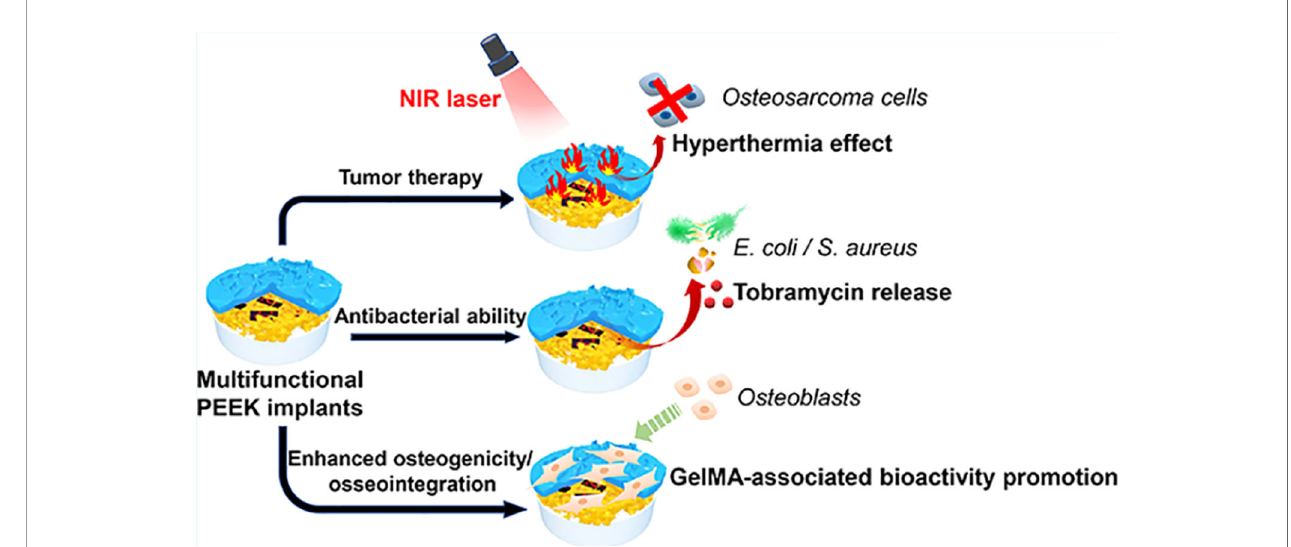
FIGURE 3 | Under 808 nm near-infrared (NIR) irradiation, SP@MX-TOB/GelMA multifunctional implants can effectively kill OS cells in conjunction with photothermal effect. In addition, SP@MX-TOB/GelMA loaded TOB showed good antibacterial properties. More importantly, the multifunctional implant has excellent cellular compatibility and osteogenic ability. Reproduced from (13) with permission from Curr Med